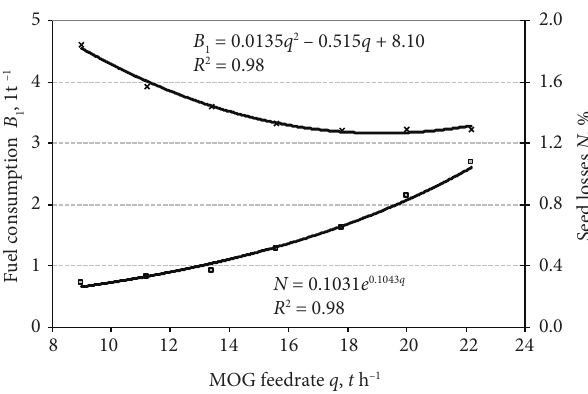
Figure 5. Effect of MOG mass of WOSR fed to combine harvester B on fuel consumption per ton of threshed seeds ( B 1 ) and on seed losses of straw walker and cleaning shoe ( N ) when straw was chopped ( n 1 = 3300 rpm), h = 0.3 m, and the grain tank contained 70% of seeds. (1) represents fuel consumption, (2) represents seed losses